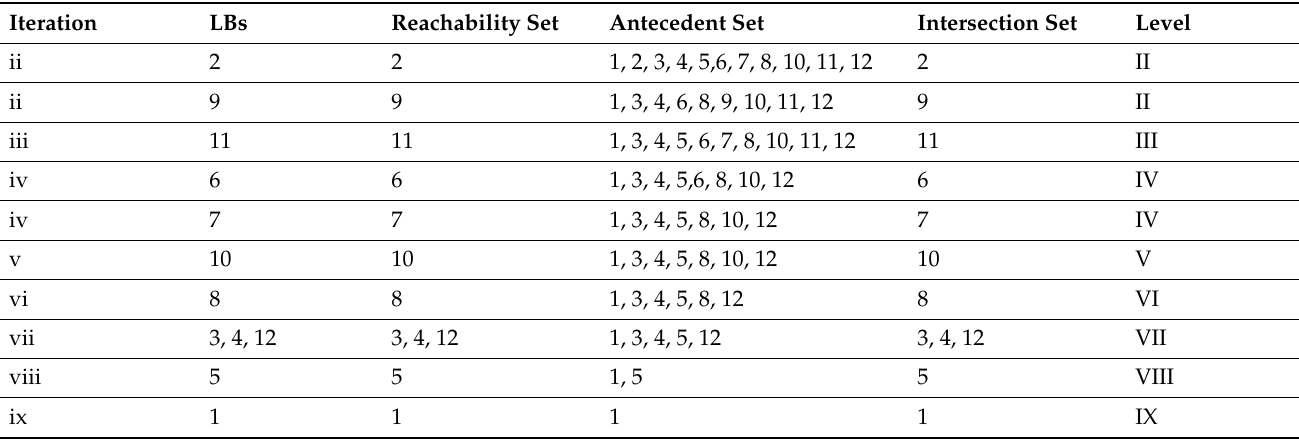
Table 6. Final iterations of lean implementation barriers